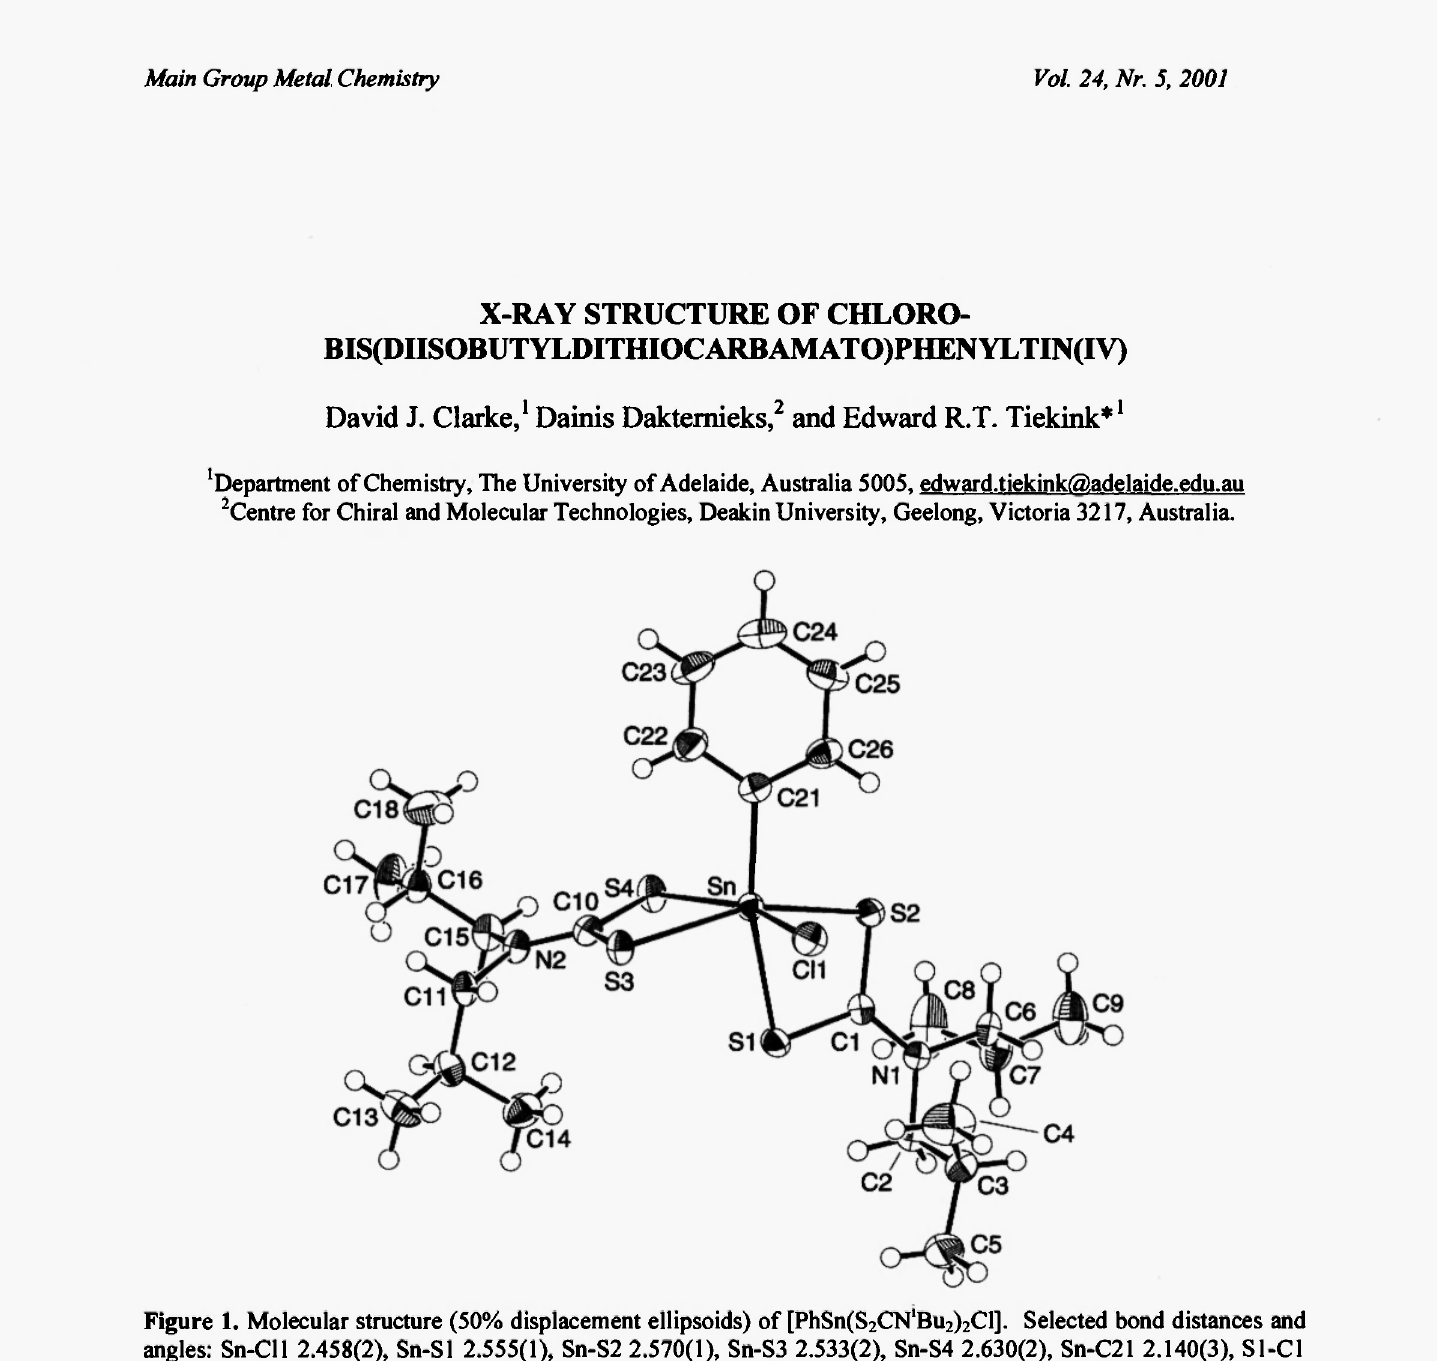
Figure I. Molecular structure (50% displacement ellipsoids) of [PhSn(S 2 CN'Bu 2 ) 2 Cl]. Selected bond distances and angles: Sn-Cll 2.458(2), Sn-Sl 2.555(1), Sn-S2 2.570(1), Sn-S3 2.533(2), Sn-S4 2.630(2), Sn-C21 2.140(3), Sl-Cl 1.730(3), S2-C1 1.725(4), S3-C10 1.743(3), S4-C10 1.716(3), Cl-Nl 1.319(4), N2-C10 1.330(4) Ä; Cll-Sn-Sl 87.39(4), Cll-Sn-S2 98.26(6), Cll-Sn-S3 92.98(6), Cll-Sn-S4 162.32(3), Cll-Sn-C21 93.3(1), Sl-Sn-S2 69.80(4), Sl-Sn-S3 88.51(4), Sl-Sn-S4 89.15(4), Sl-Sn-C21 166.13(9), S2-Sn-S3 154.93(3), S2-Sn-S4 96.79(6), S2-Sn-C21 96.4(1), S3-Sn-S4 69.60(6), S3-Sn-C21 105.3(1), S4-Sn-C21 94.2(1), Sn-Sl-Cl 86.1(1), Sn-S2-Cl 85.8(1), Sn-S3- C10 88.0(1), Sn-S4-C10 85.4(1), S1-C1-S2 166.1(2) and S3-C10-S4